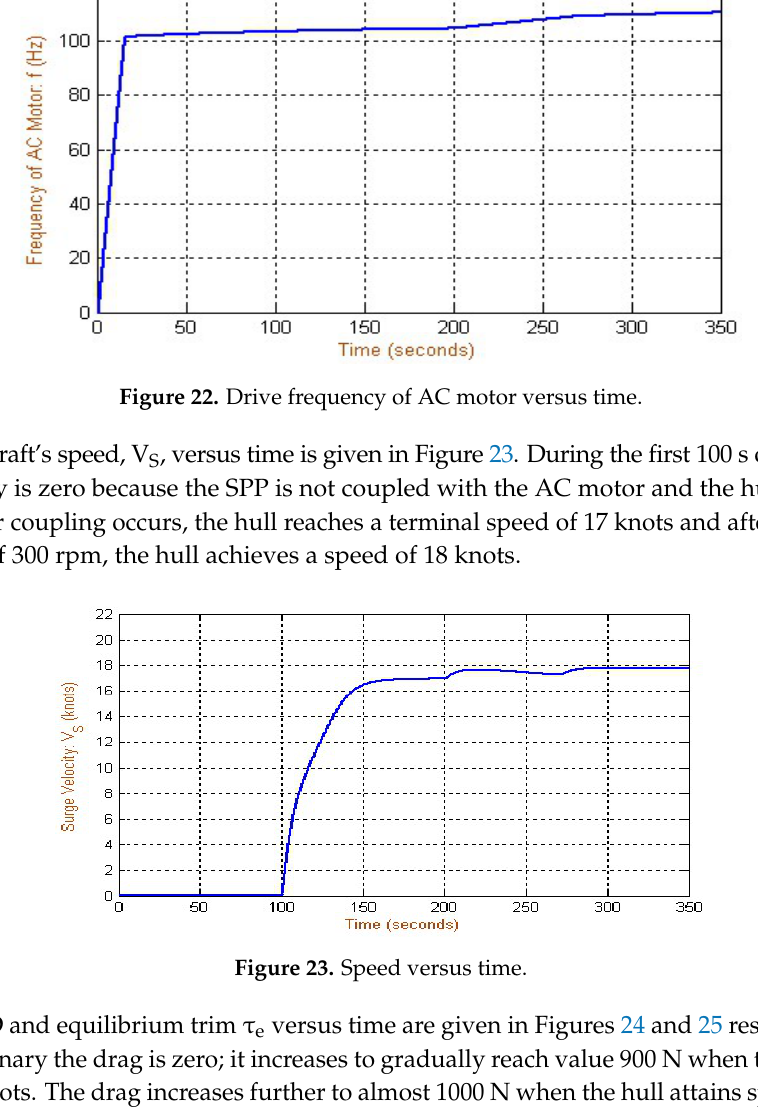
Figure 21. Electromagnetic torque versus time.